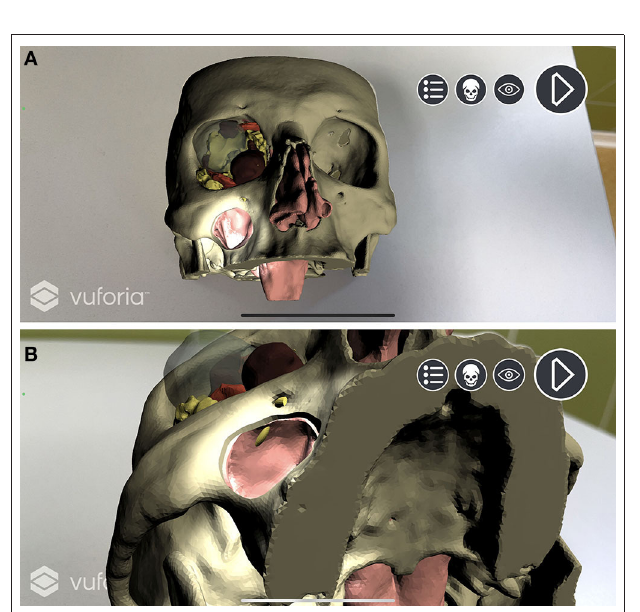
FIGURE 6 | Depth mask rendering. Soft tissues are correctly displayed without the skull virtual model. (A) Depth mask is disabled and anatomical structures are simulated as “seen through” the printed model. (B) Depth mask is enabled and soft tissues are seen in their natural position on the printed